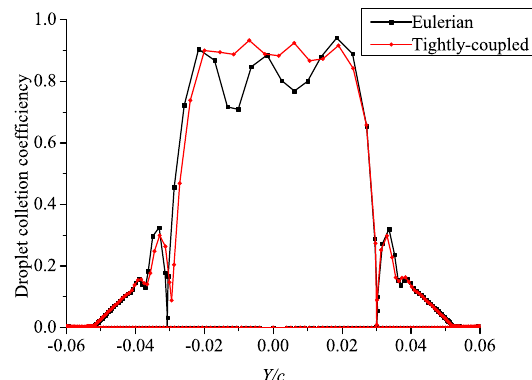
Figure 22. Distribution of the droplet collection coefficient at t = 804